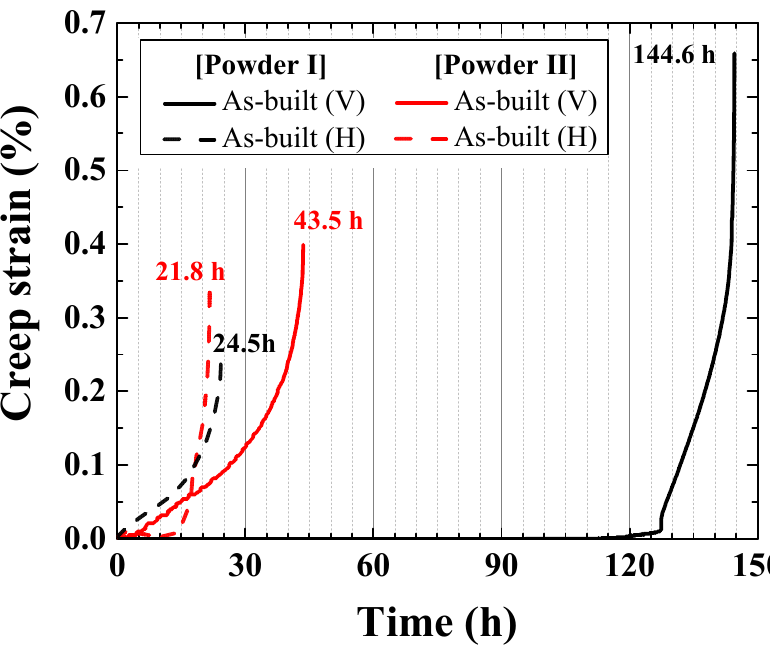
Figure 10. Powder I and II as-built creep test results and creep rupture time change comparison. Powder I is indicated by black lines, and Powder II is indicated by red lines. The vertical (V) and horizontal (H) as-built specimens are indicated by solid lines and dotted lines, respectively.